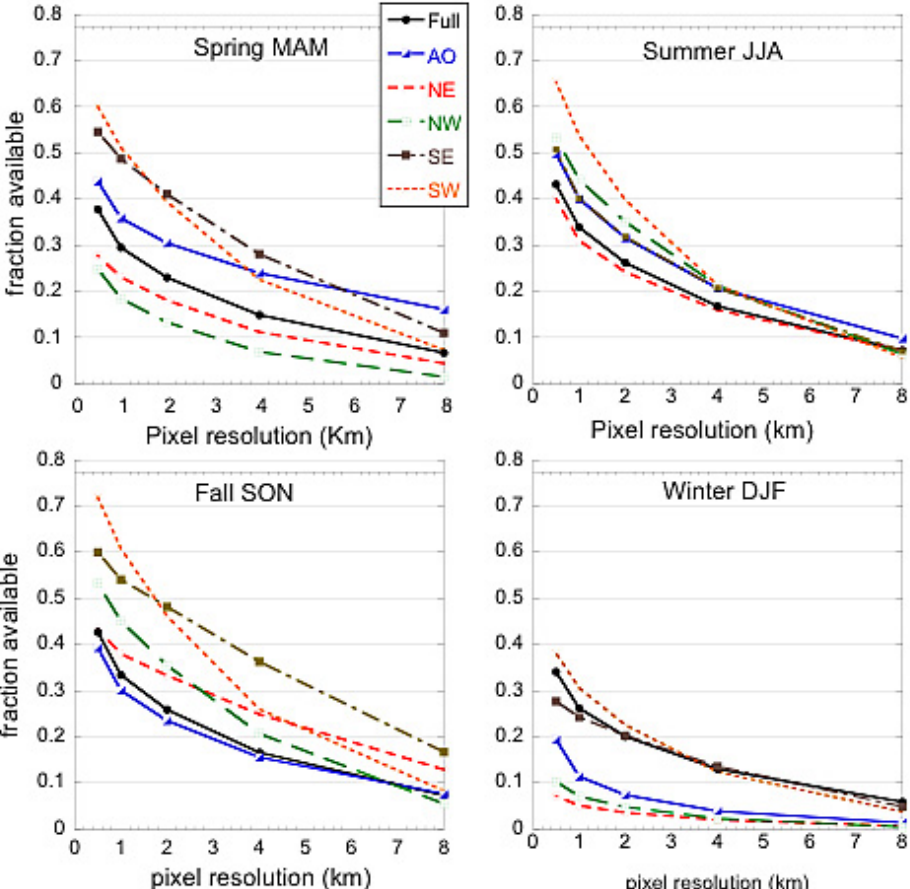
Fig. 6. Calculated availability of an aerosol retrieval as a function of instrument pixel size for the full domain and subdomains defined in Fig. 5, for the four